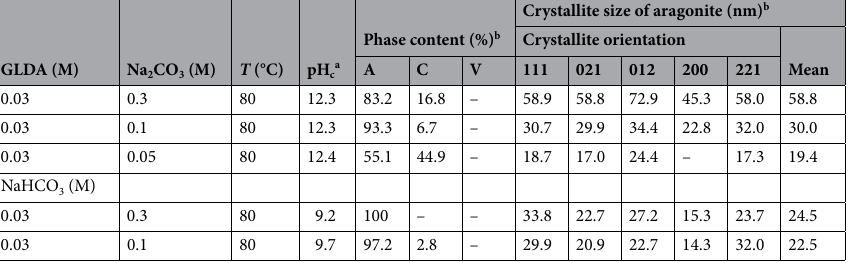
Table 2. Selected parameters of CaCO 3 particles obtained under various carbonation conditions. A: aragonite, C: calcite, V: vaterite. a pH c refers to the pH measured after 60-min carbonation. b Phase compositions and aragonite crystallite sizes were determined from XRD data using MDI Jade 6.